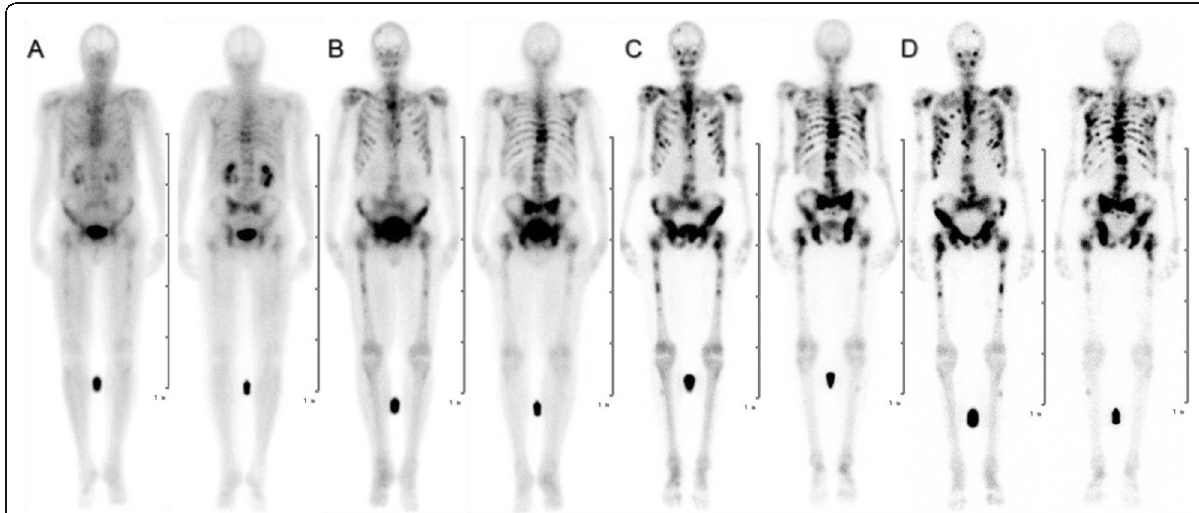
Fig. 3 Planar scintigraphy (anterior and posterior views) after therapeutic application of [ 177 Lu]Lu-DOTA ZOL at a 20 min, b 3 h, c 24 h, and d 168 h in a patient with bone metastases secondary to prostate cancer (patient no.